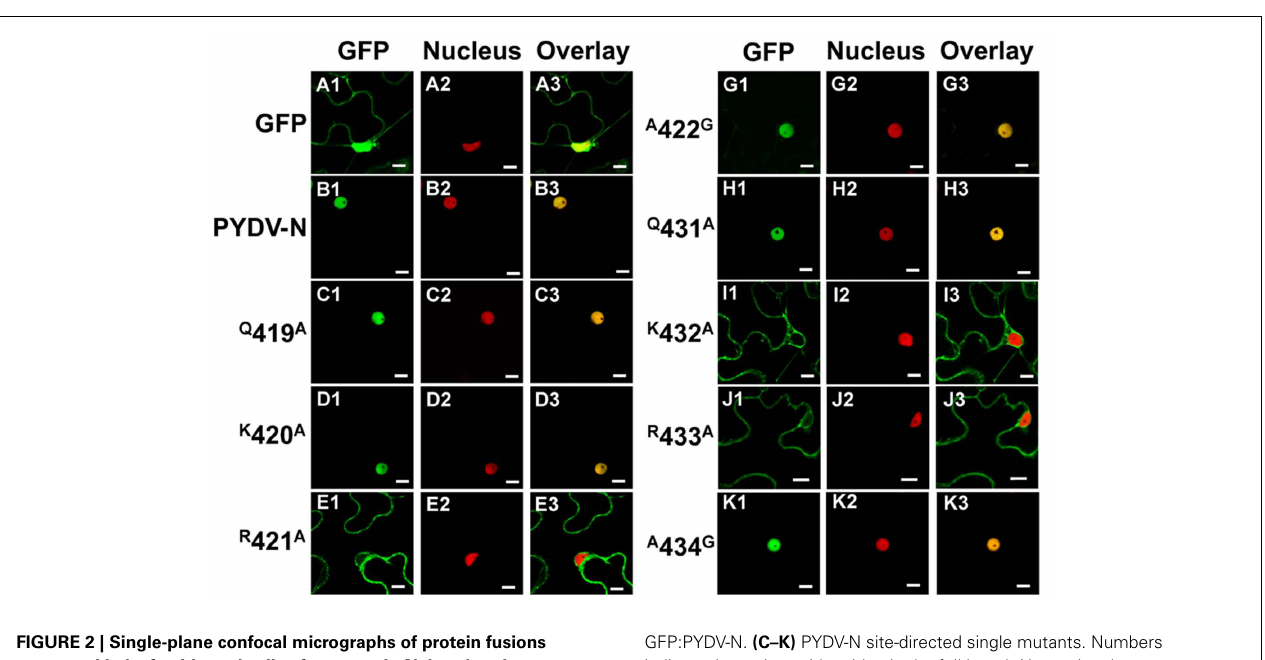
FIGURE 2 | Single-plane confocal micrographs of protein fusions expressed in leaf epidermal cells of transgenic N. benthamiana plants expressing RFP fused to a nuclear marker, histone 2B. Shown in panels 1, 2, and 3 are micrographs of GFP (fusions), RFP, and the resultant overlay, respectively. (A1–A3) GFP only.